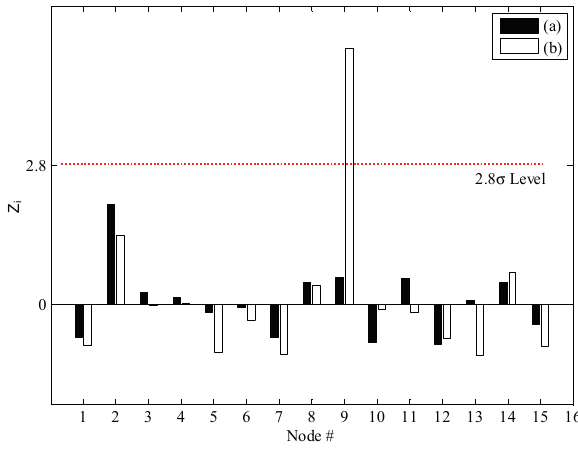
Figure 3. Results of damage detection using the ULS method: ( a ) DC1 and ( b ) DC2.